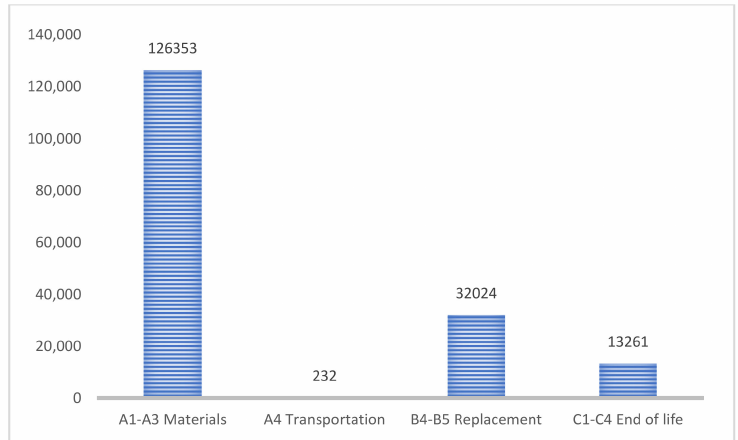
Figure 7. Scenario B: Global warming kg CO 2 -life-cycle stages.